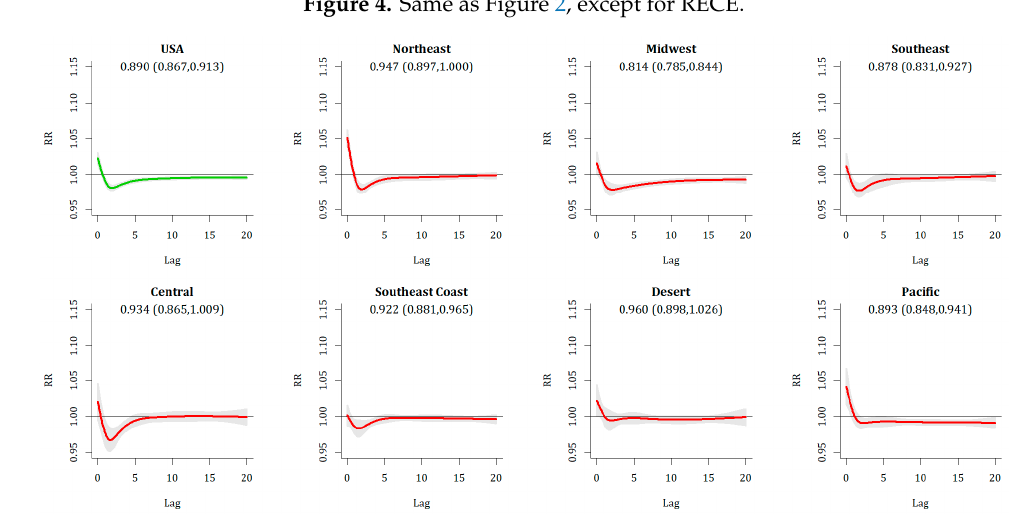
Figure 5. Same as Figure 2, except for REHE.